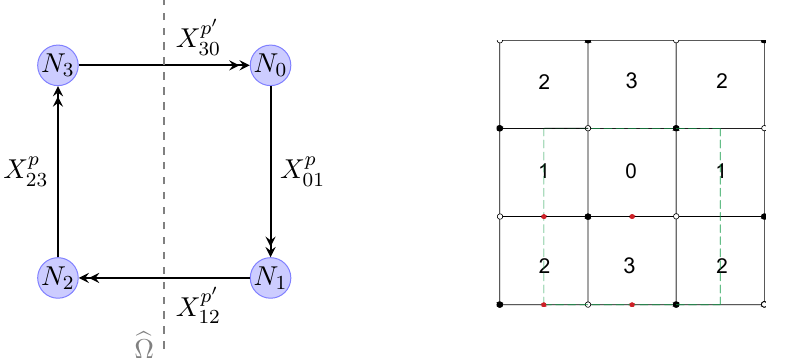
Figure 18. The orientifold projection b (cid:10) of C = Z 0 on the right.